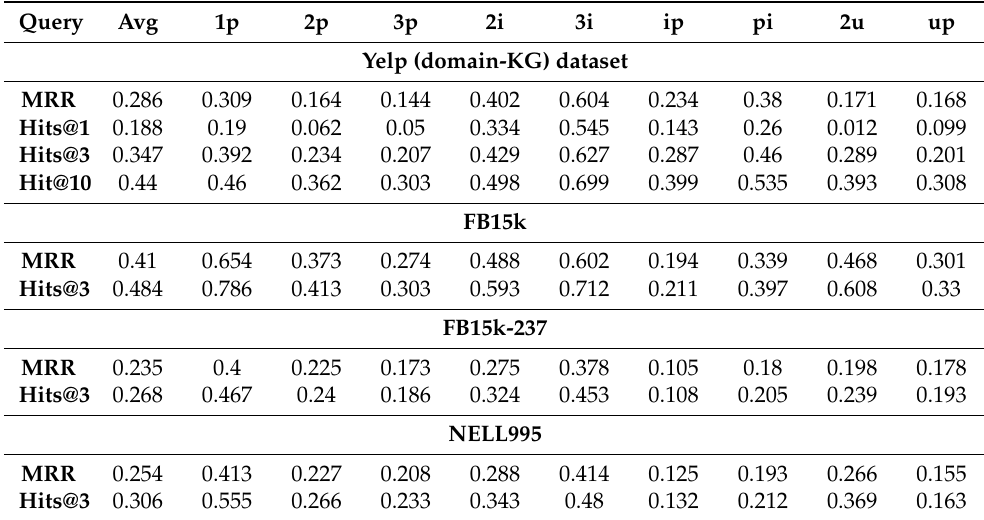
Table 5. Results of Q2B on restaurant domain dataset for different query structures. The other dataset results are illustrated from the original paper for